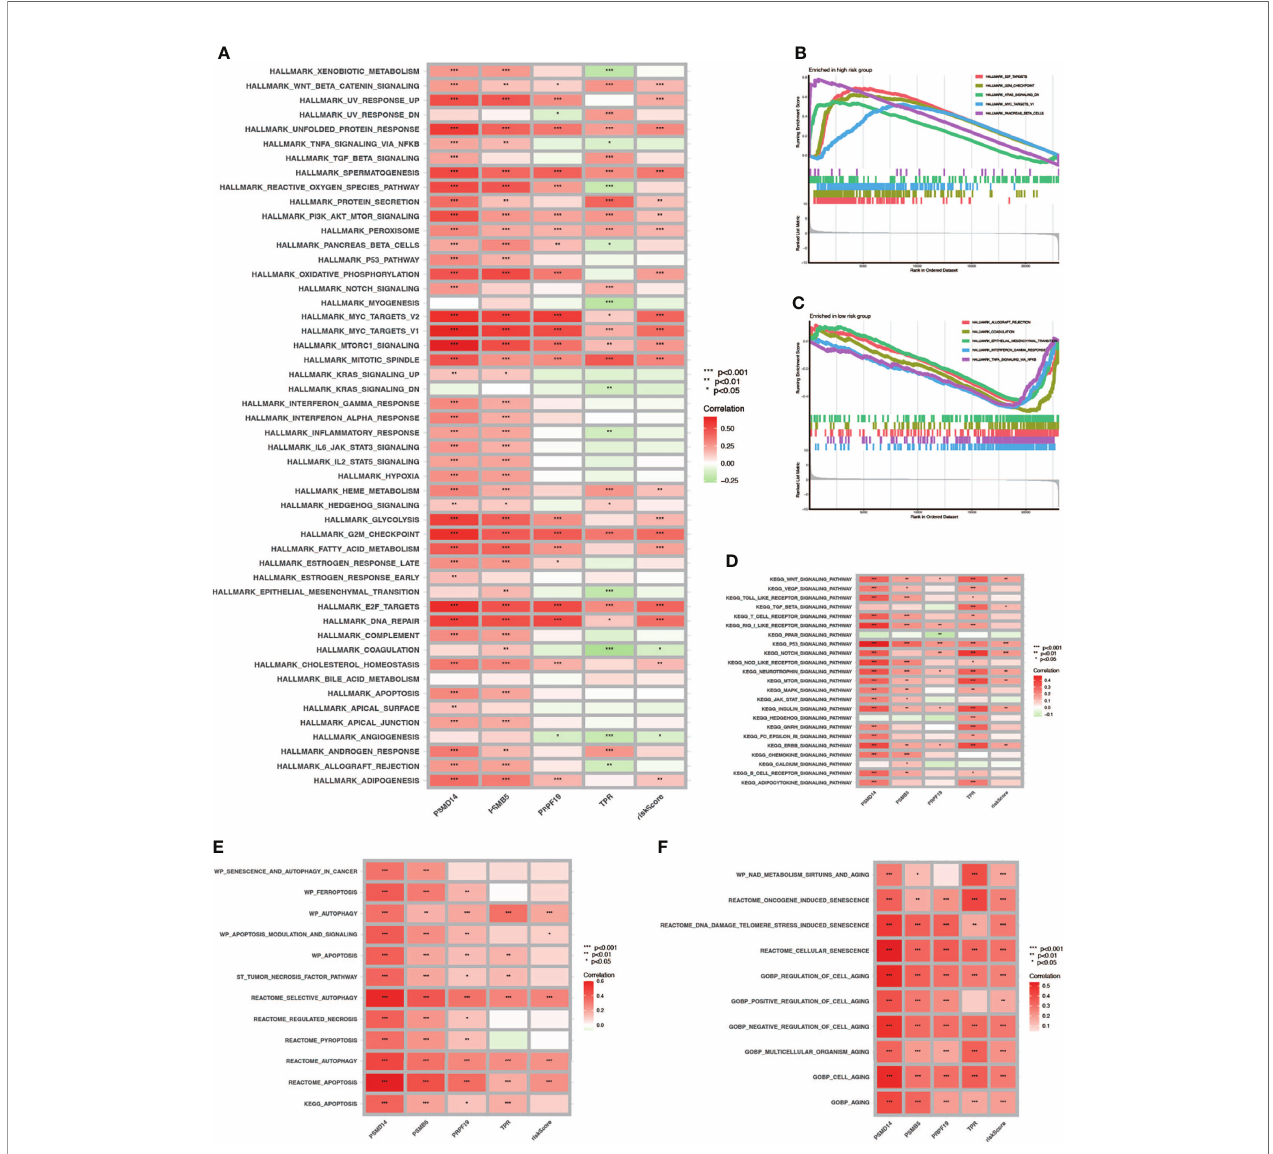
FIGURE 8 | GSVA and GSEA. (A) GSVA in Hallmark gene sets. (B, C) GSEA in high- and low-risk-score patients. (D) GSVA in the KEGG database. (E) Correlation between cell death mode and risk score. (F) Correlation between cell aging related pathways and risk score (* P < 0.05; ** P < 0.01; *** P <